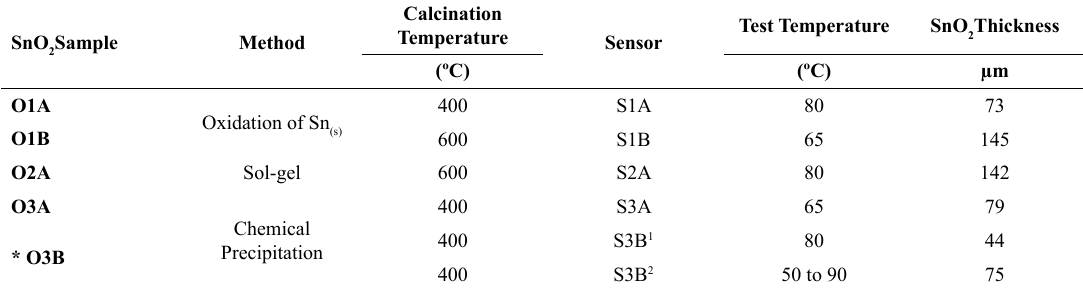
Table 1. Symbology and synthesis conditions for tin oxide and the solid-state sensors produced. SnO 2